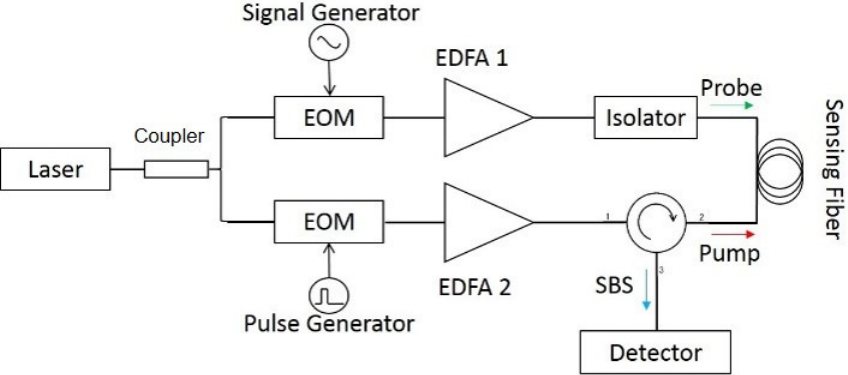
Figure 1. Basic layout of a BOTDA system.